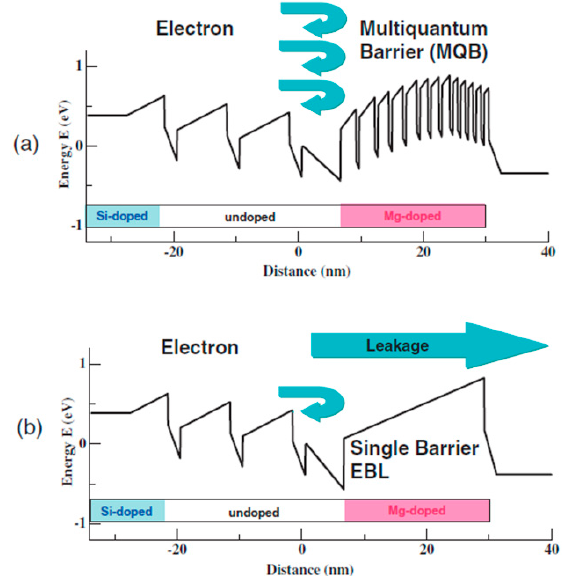
Figure 2. Schematic of electron injection into multiple quantum wells (MQWs) in AlGaN-based DUV LEDs using ( a ) a multiple quantum barrier (MQB) and ( b ) a single barrier electron blocking layer (EBL). Reprinted with permission from [17]. Copyright 2014, The Japan Society of Applied Physics.